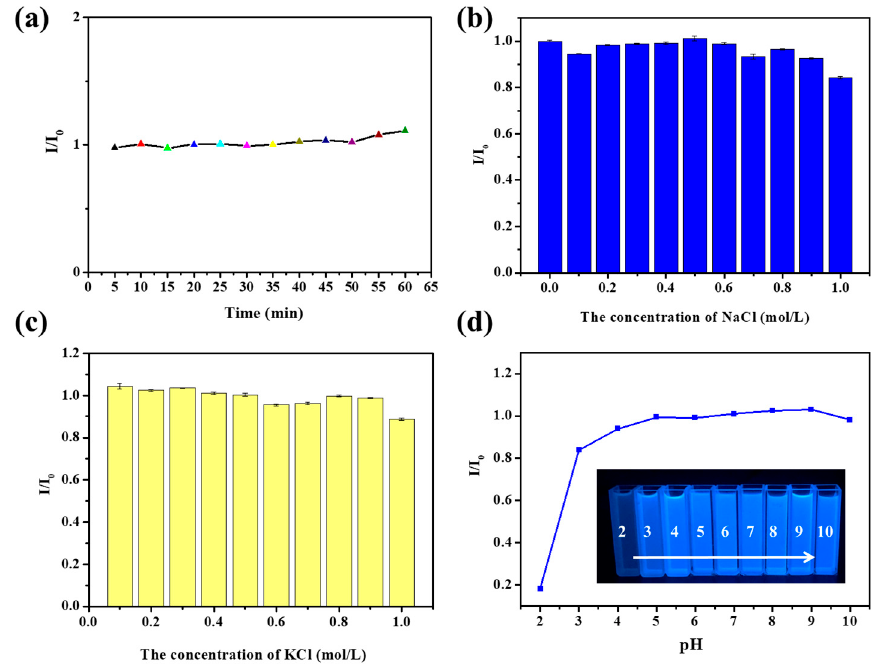
Figure 6. ( a ) FL intensities of FA-PDA FONs under 365 nm UV lamp with different illumination time; ( b ) FL intensities of FA-PDA FONs in different concentrations of NaCl; ( c ) FL intensities of FA-PDA FONs in different concentrations of KCl; ( d ) FL intensities of FA-PDA FONs in the different pH solution, inset shows the photographs of FA-PDA FONs in different pH solution under the irradiation of 365 nm UV lamp.